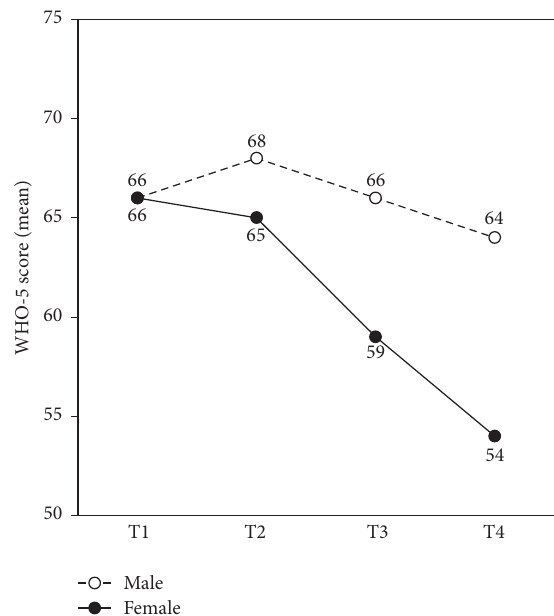
Figure 2: Gender breakdown of the change of dental students’ positive well-being across the second academic semester.